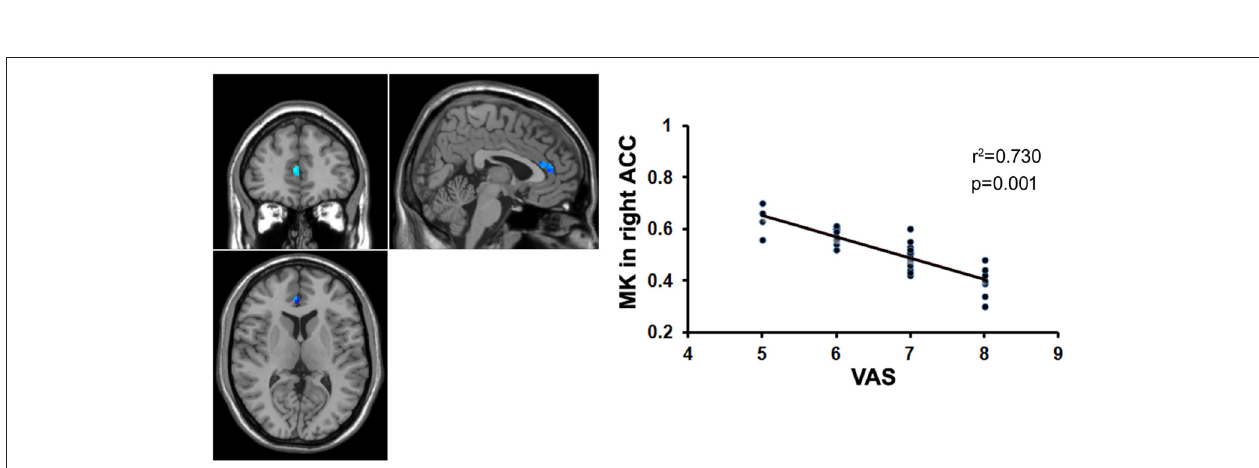
FIGURE 5 | Correlation, analysis between the AK value and the VAS score. There was significant negative correlation between the AK value in the right mPFC and the VAS score in patients with chronic myofascial pain.